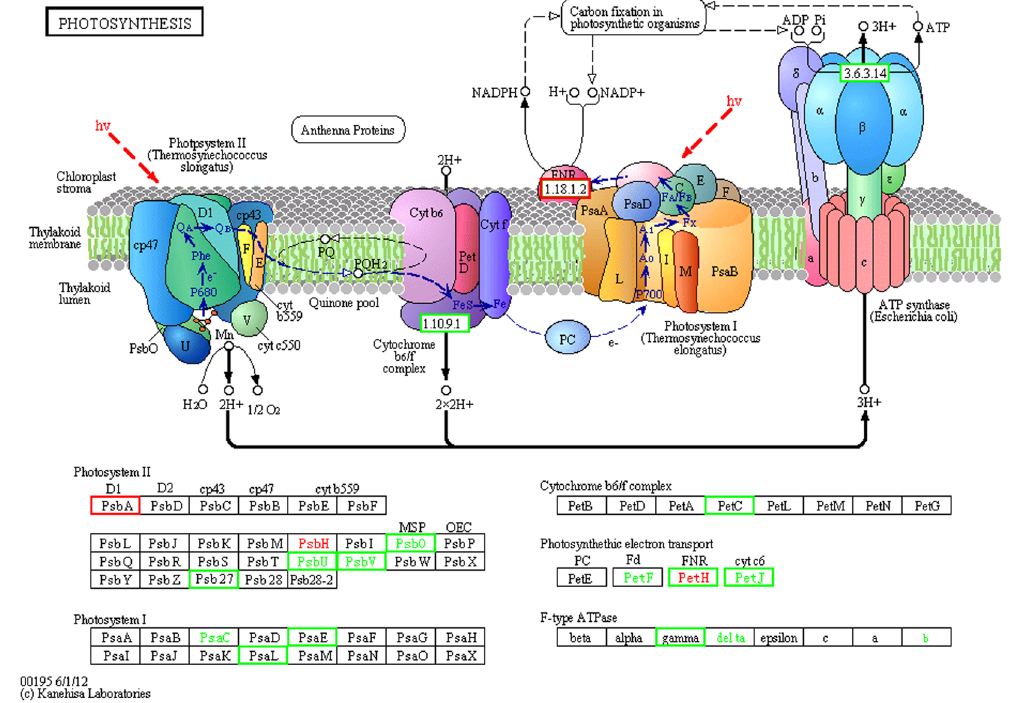
Figure 3. The KEGG photosynthesis pathway map for T. pseudonana during N depletion compared to N replete conditions (ND vs. NR). The KEGG photosynthesis pathway map can be found online at http://www. kegg.jp/pathway/map00195. The light green boxes indicate the genes were down-regulated and up-expressed (red boxes). The highlighted in red indicate the protein represent up-expressed and down-expressed (green word). The detail fold-change and annotation of these genes were summarized in Table 1 and Dataset